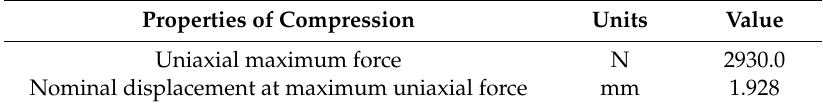
Table 11. Mechanical properties for the printed element achieved in the uniaxial compression test on the X–Y-axis.